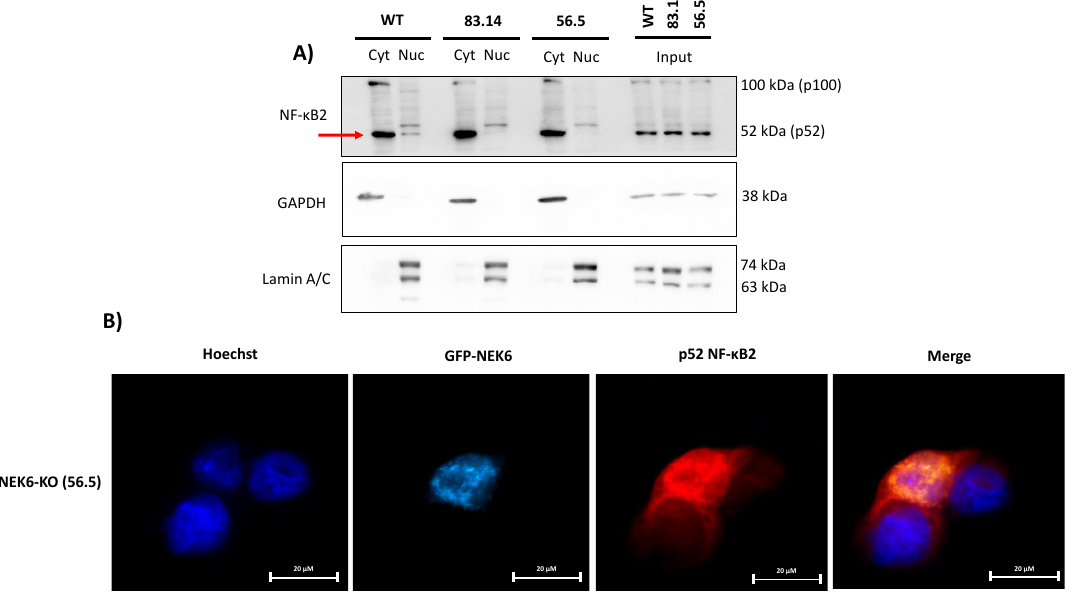
Figure 7. NEK6 is involved in the nuclear translocation of NF-κB2.